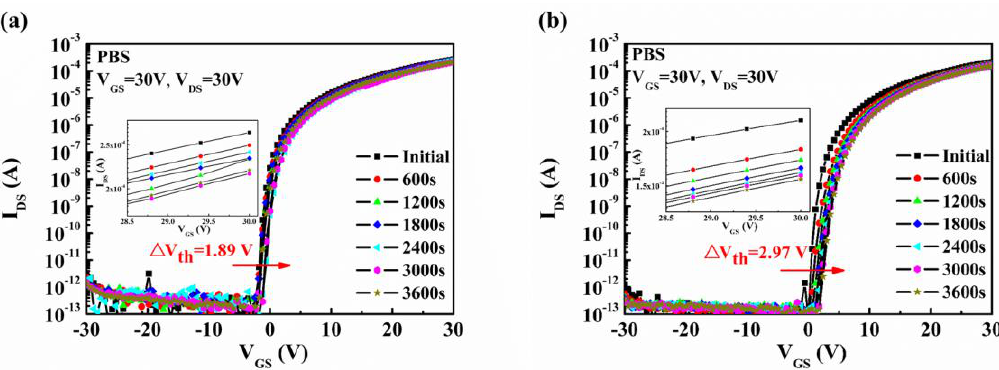
Figure 5. The evolution of time-dependent transfer curves under positive gate bias stress for a-STO TFTs with different S/D electrodes: ( a ) ITO, ( b ) Mo. The inserts show the variation of the on-current as a function of time.